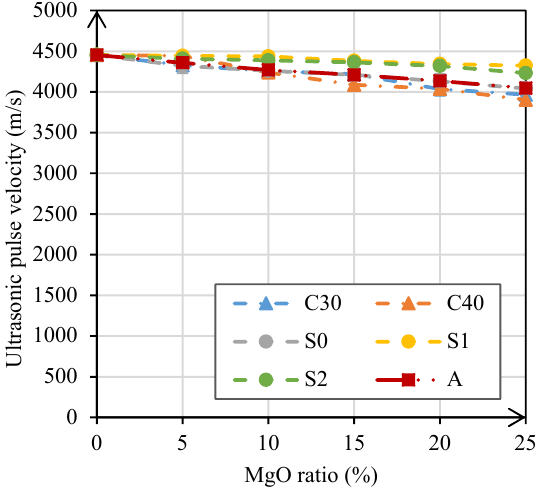
Figure 9. Ultrasonic pulse velocity versus MgO content.